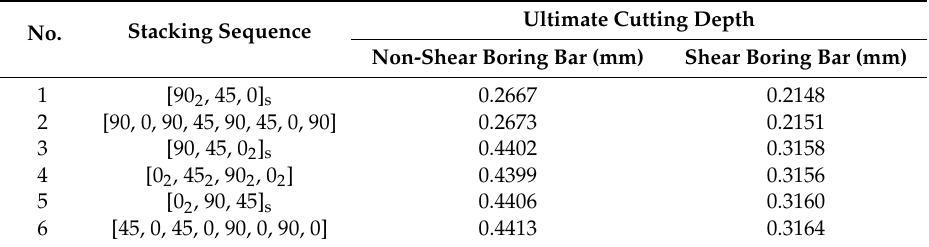
Table 4. Comparison of the ultimate cutting depth of composite boring bars.